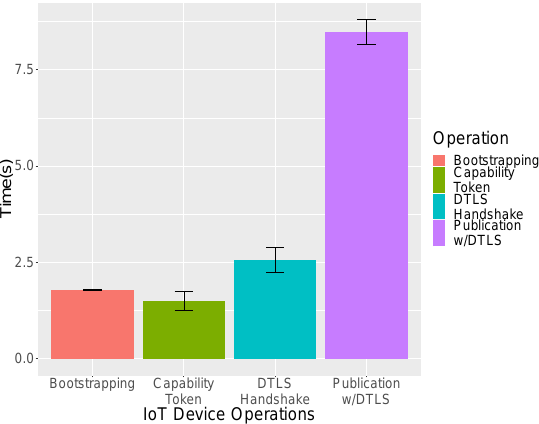
Figure 8. Mean time of each IoT operation (AuthN, AuthZ, Channel Protection).